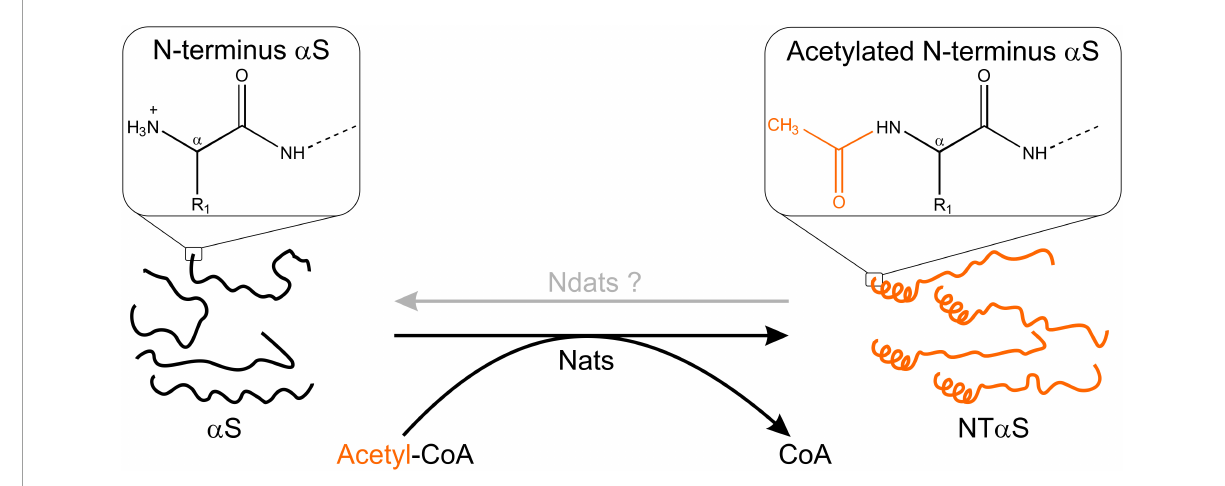
FIGURE2 Schematic outline of N-terminal acetylation. N-terminal acetyltransferases (Nats) catalyze the transfer of an acetyl group (CH 3 CO) from acetyl-CoA (Ac-CoA) to the free α -amino group of the protein N-terminus. The transferred acetyl group eliminates a positive charge at the protein N-terminus. In the case of α S, N - α -acetylation has been shown to induce helix formation in the first 16 residues (Maltsev et al., 2012). The existence of N-terminal de-acetyltransferases (Ndats) is unknown.